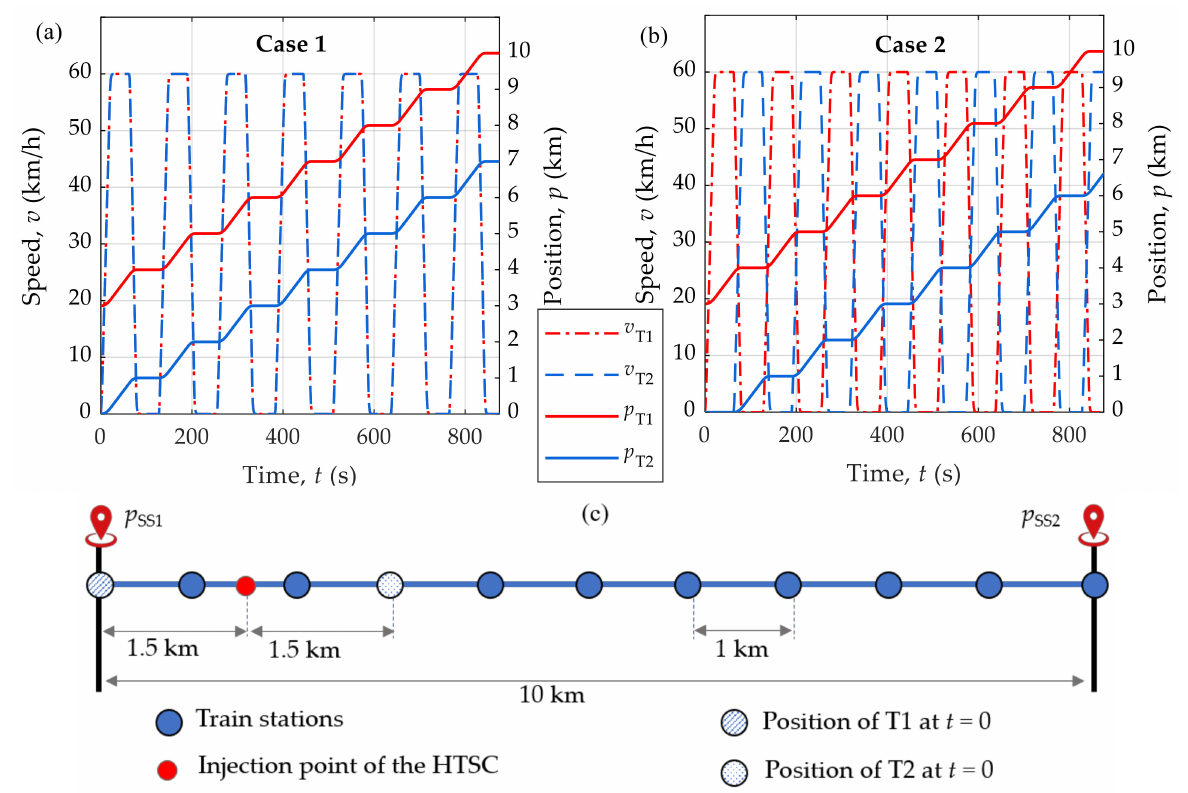
Figure 17. Speed v and position p of each train; ( a ) case 1 represents the case where both trains follow the same speed profile at the same time, while ( b ) case 2 represents the case where the speed profiles are shifted by about one minute. ( c ) At t = 0, the distance between the two trains is equal to 3 km.